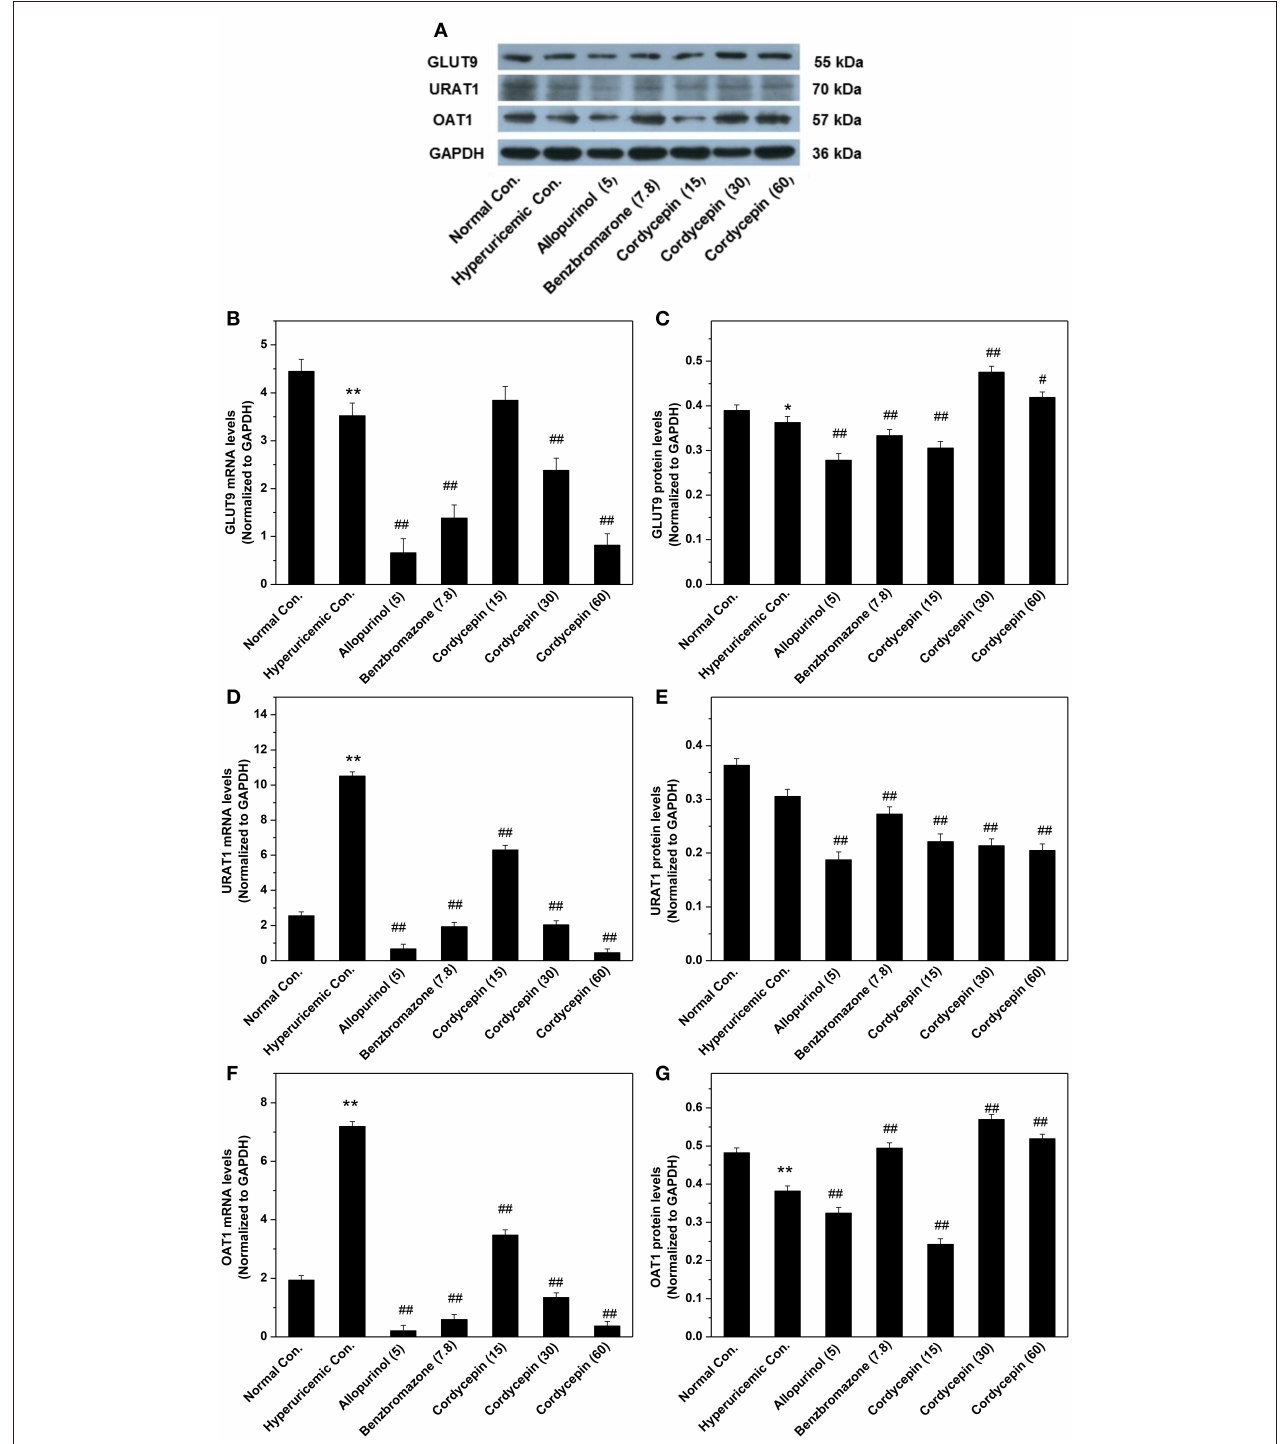
FIGURE 6 | Affections of cordycepin on mRNA and protein of renal GLUT9 (A–C) , URAT1 (A,D,E), and OAT1 (A,F,G) . * P < 0.05, ** P < 0.01 vs. normal control; # P < 0.05, ## P < 0.01 vs. hyperuricemic control.